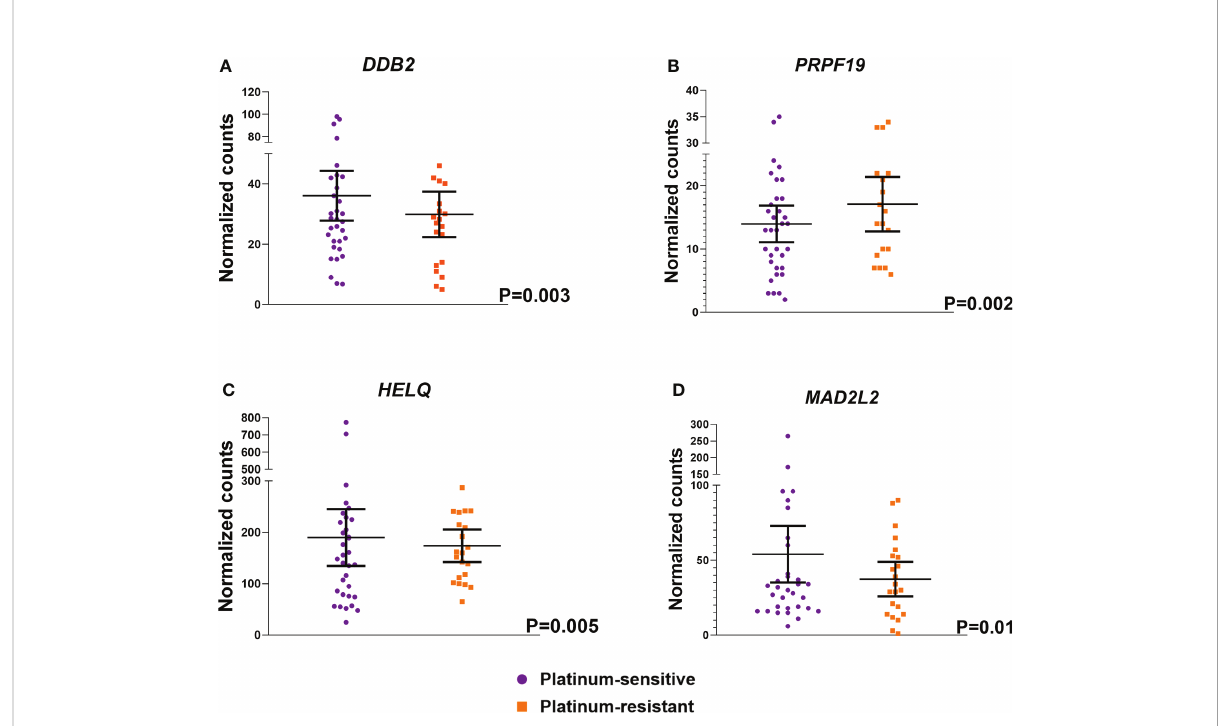
FIGURE 2 Differentially expressed DNA repair genes based on the response of EOC patients to platinum based chemotherapy. Analysis of differential expression between platinum-sensitive patients and the platinum-resistant ones showed four differentially expressed genes – (A) DDB2 , (B) PRPF19 , (C) HELQ and (D) MAD2L2 . EOC patients were divided as platinum-sensitive (N=37, purple color) and platinum-resistant (N=23, orange color) based on the platinum resistance status determined by platinum-free interval